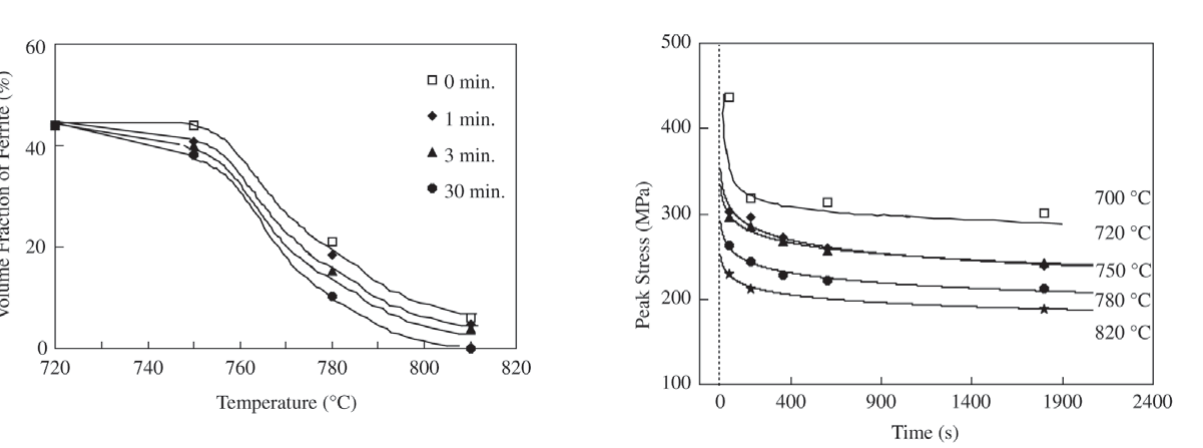
Figure 4. Dependence of the peak stress on the holding time be- fore deformation.